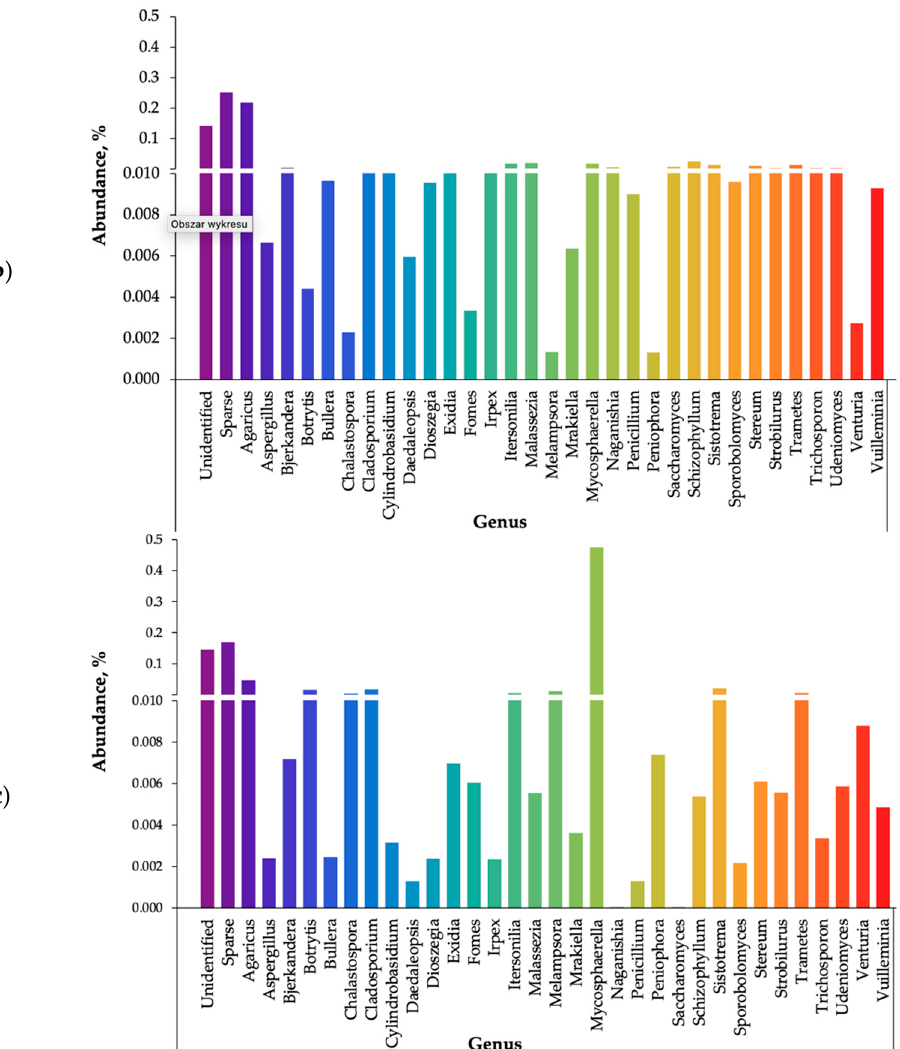
Figure 7. Phylogenetic distribution of fungi sequences in the settled dust sample; ( a ) assigned to the phyla, ( b ) assigned to the genera in sport facility; ( c ) assigned to the genera in control air; unidentified—unidentified sequences; sparse—reads assigned to low abundant phyla (less than 0.5% of all classified reads).